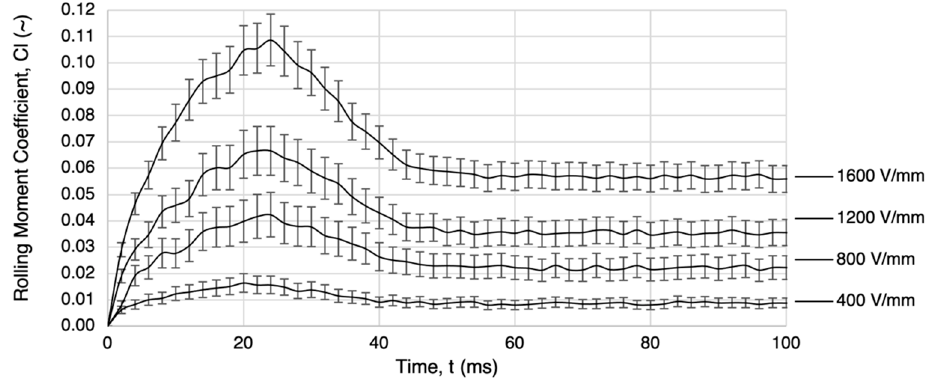
Figure 15. Rolling moment coefficient about the wing root, 80 ft/s (24.4/s), Rn = 127,000.